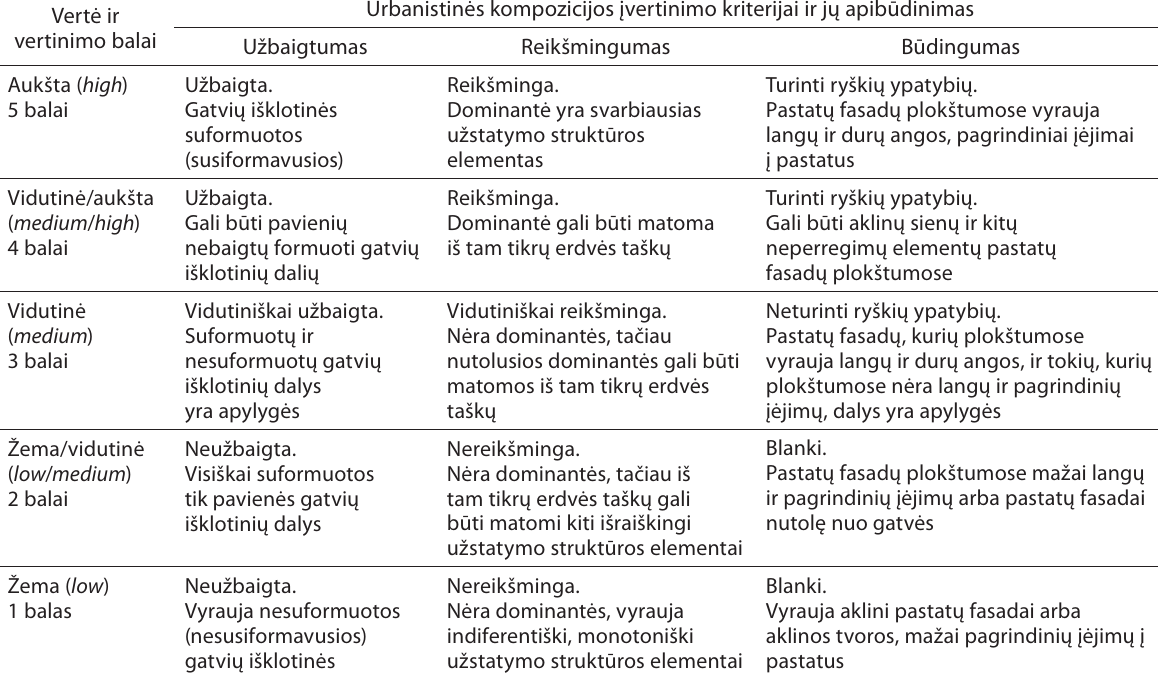
Table 1. Definition of the evaluative criteria of urban composition Vertė ir vertinimo